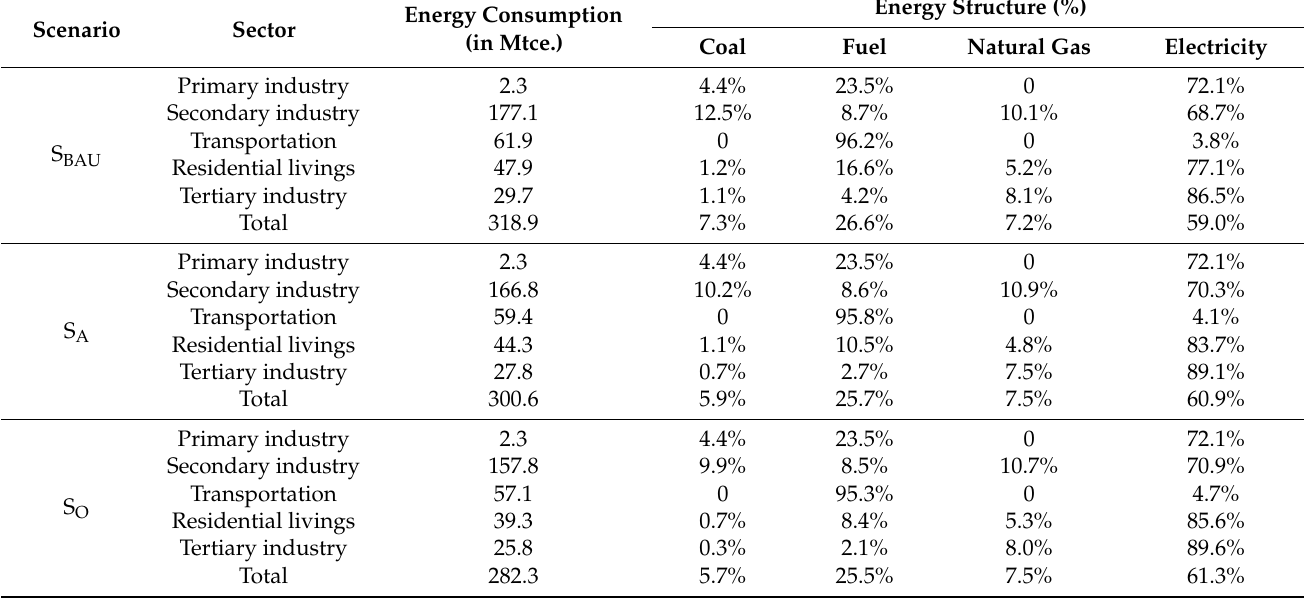
Table 2. Energy structure development of